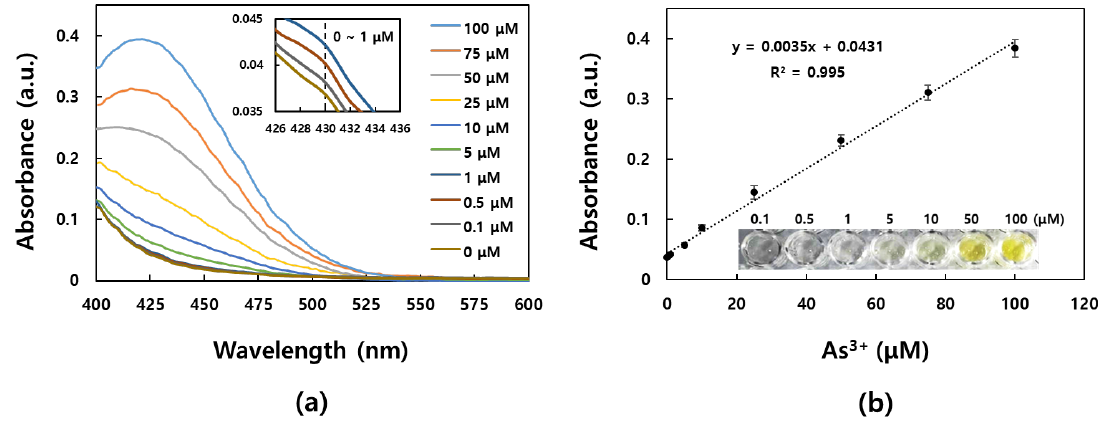
Figure 5. Quantitative analysis of As 3 + : ( a ) Absorption spectra as a function of the increasing concentration of As 3 + (0.1, 0.5, 1, 5, 10, 50, and 100 µ M). Inset: image of mixtures of As 3 + and N-Tyr solution with increasing As 3 + . ( b ) Plot of the calculated absorption intensity at 430 nm corresponding to the absorption spectra against As 3 + concentrations ( n = 6). Inset: a magnified view of the plot in the range from 0.1 to 1 µ M, with fitting equation and R 2 value (0.995).